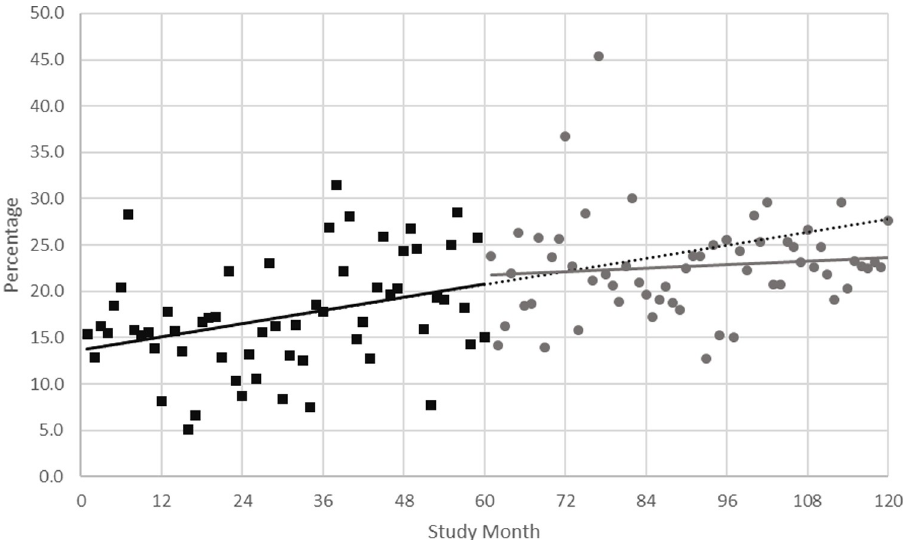
Fig 1. Percentage of repeat call admissions per month representing the ARIMA univariate model. Phase 1 monthly observed data in black squares, with slope illustrated by the solid black line. Phase 2 monthly observed data in grey circles, with slope illustrated by the solid grey line. The slope in Phase 1 is extended into Phase 2 and represented by the dotted black line for comparison with Phase 2 observed data.